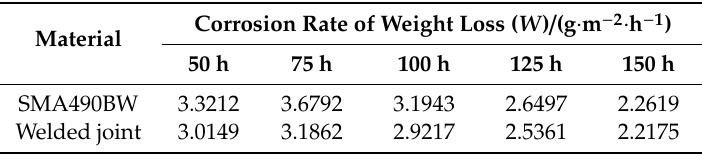
Table 3. Corrosion weight loss of the specimens.